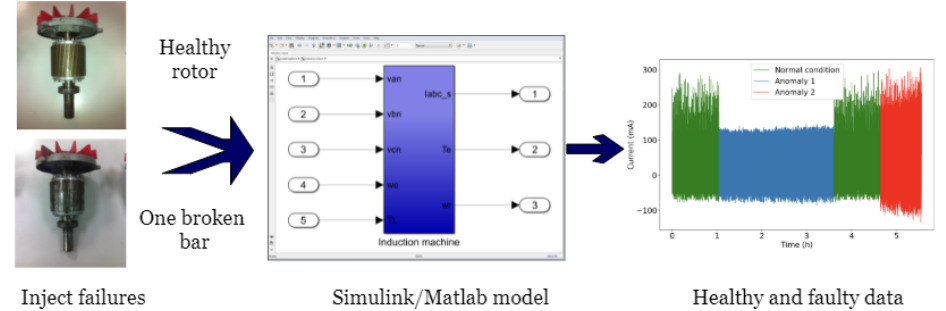
Figure 1. General process of healthy and faulty data